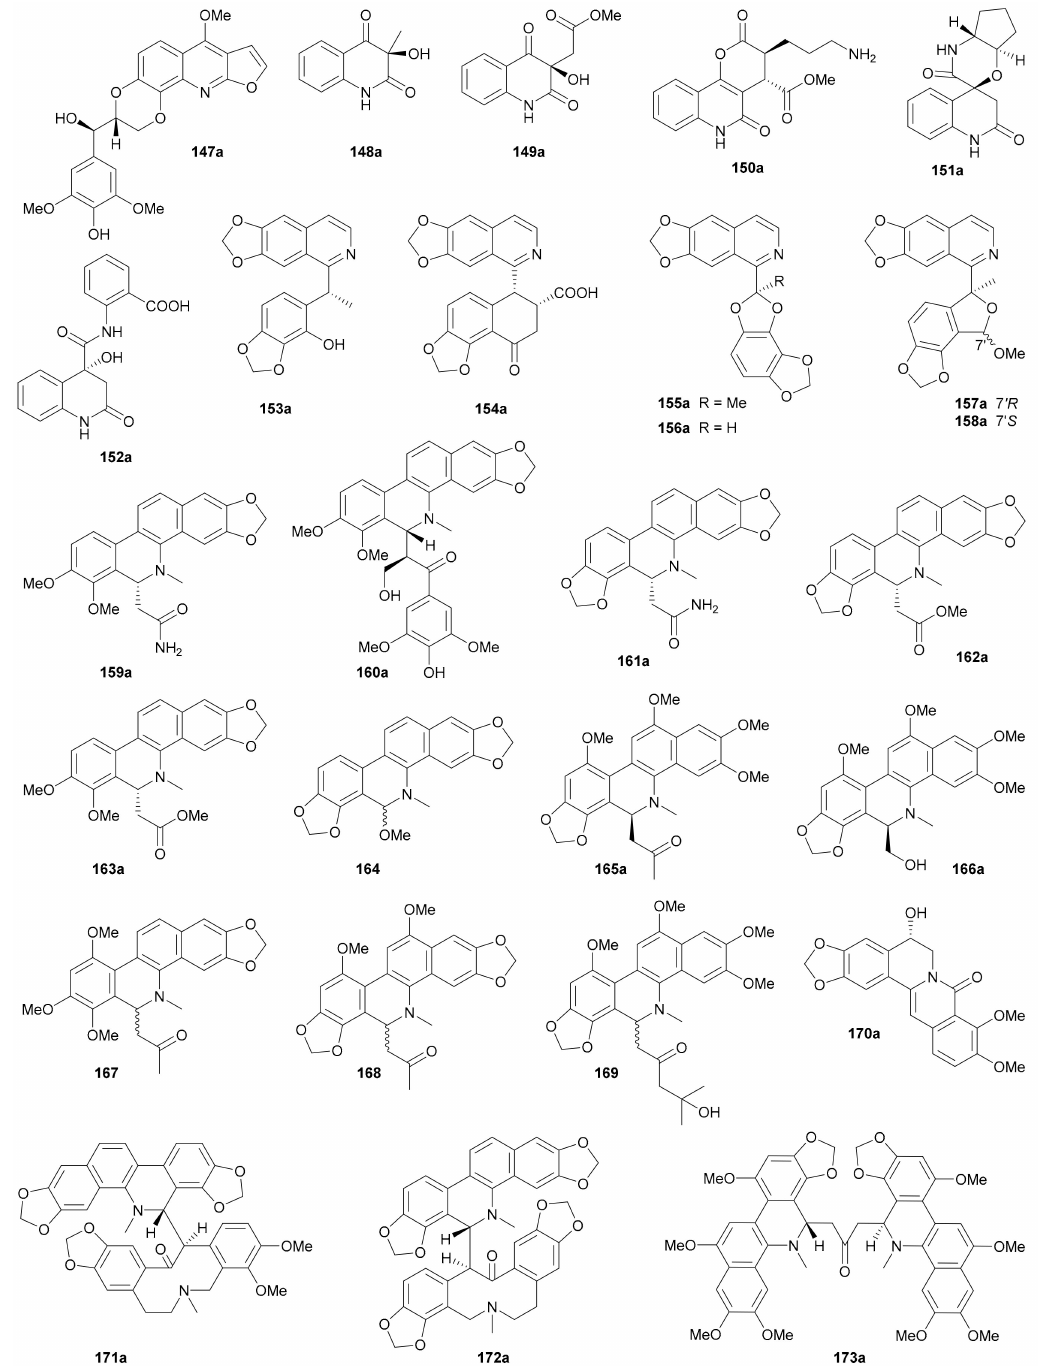
Figure 9. Structures of quinoline and isoquinoline